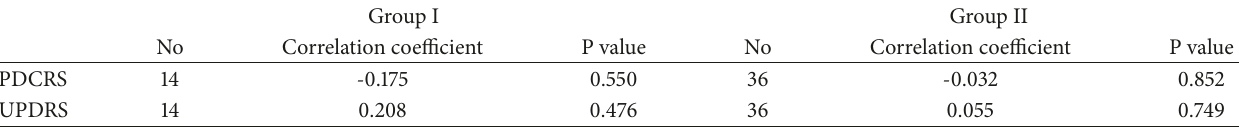
Table 5: Correlations between the duration of illness and rating scales in Group I and Group II